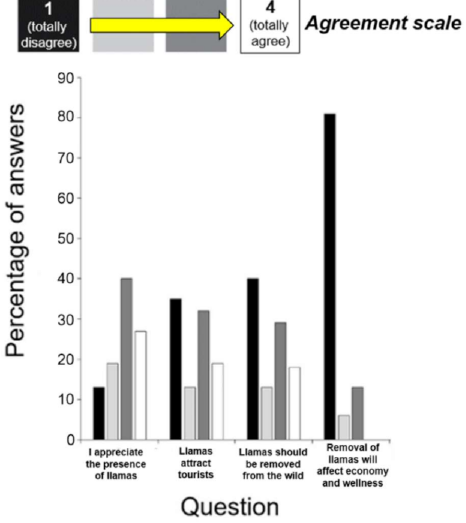
Figure 4. Frequency of answers to the survey on social perception: questions 1–2) social perception; questions 3–4) attitudes toward local removal of